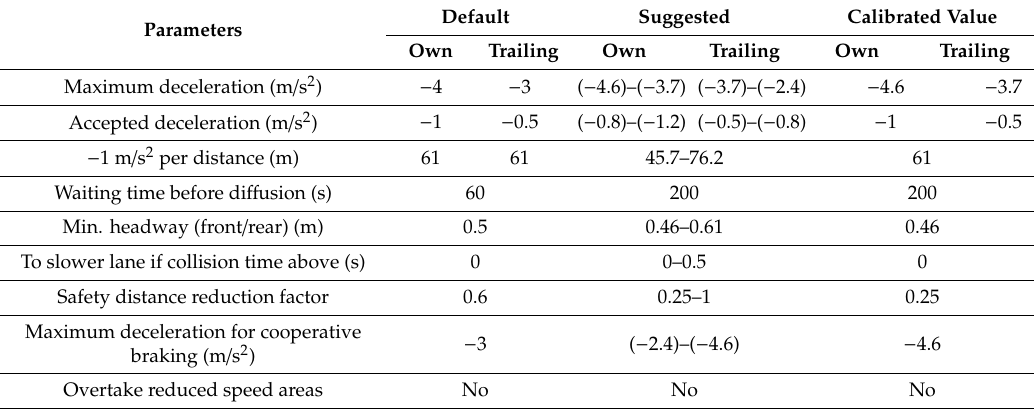
Table 2. Selected values for the parameters of the necessary lane-change model.